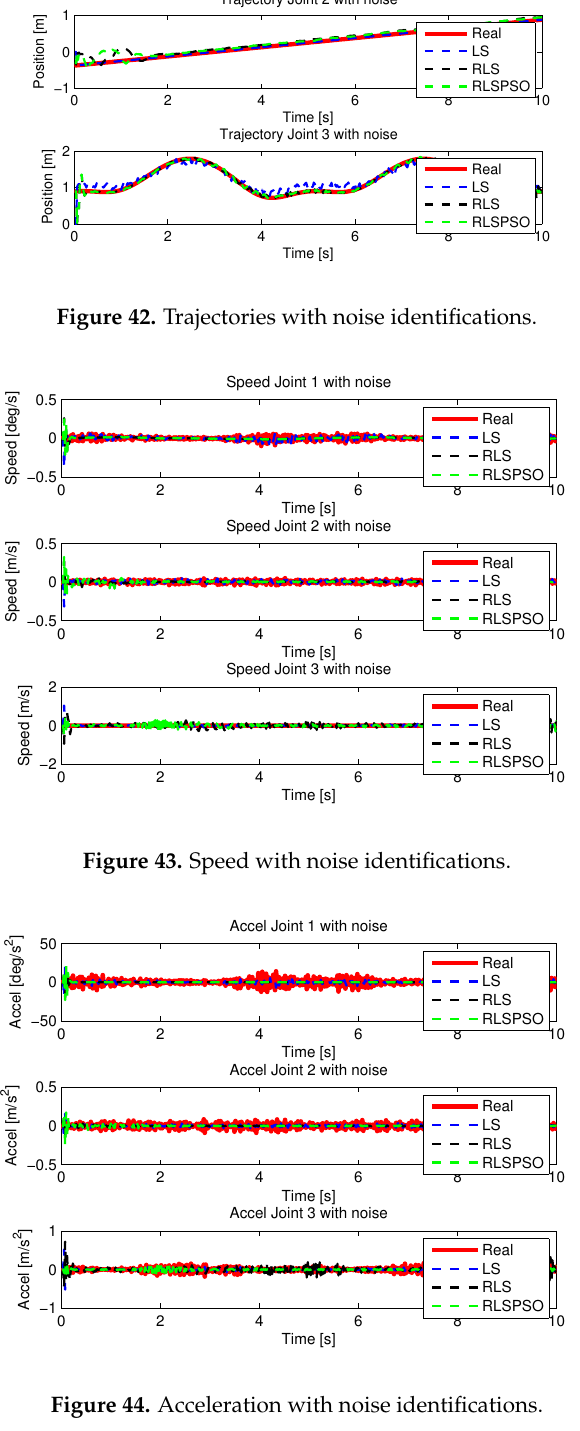
Figure 44. Acceleration with noise